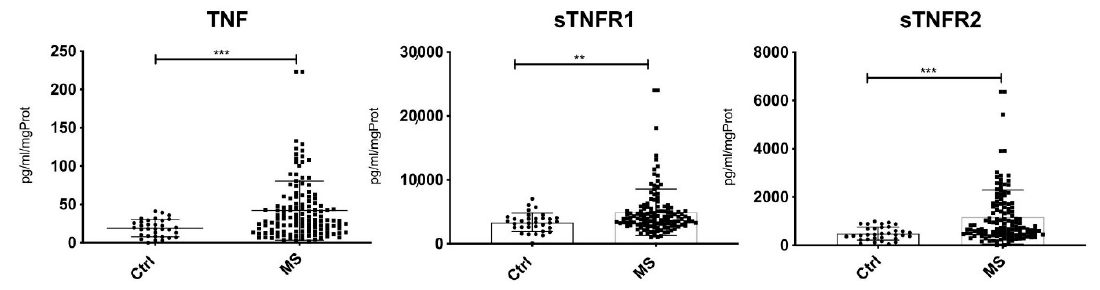
Figure 1. Significant increased levels of TNF (*** p < 0.001), sTNFR1 (** p < 0.01) and sTNFR2 (*** p < 0.001) were detected in the CSF of MS patients compared to the control group at time of diagnosis.